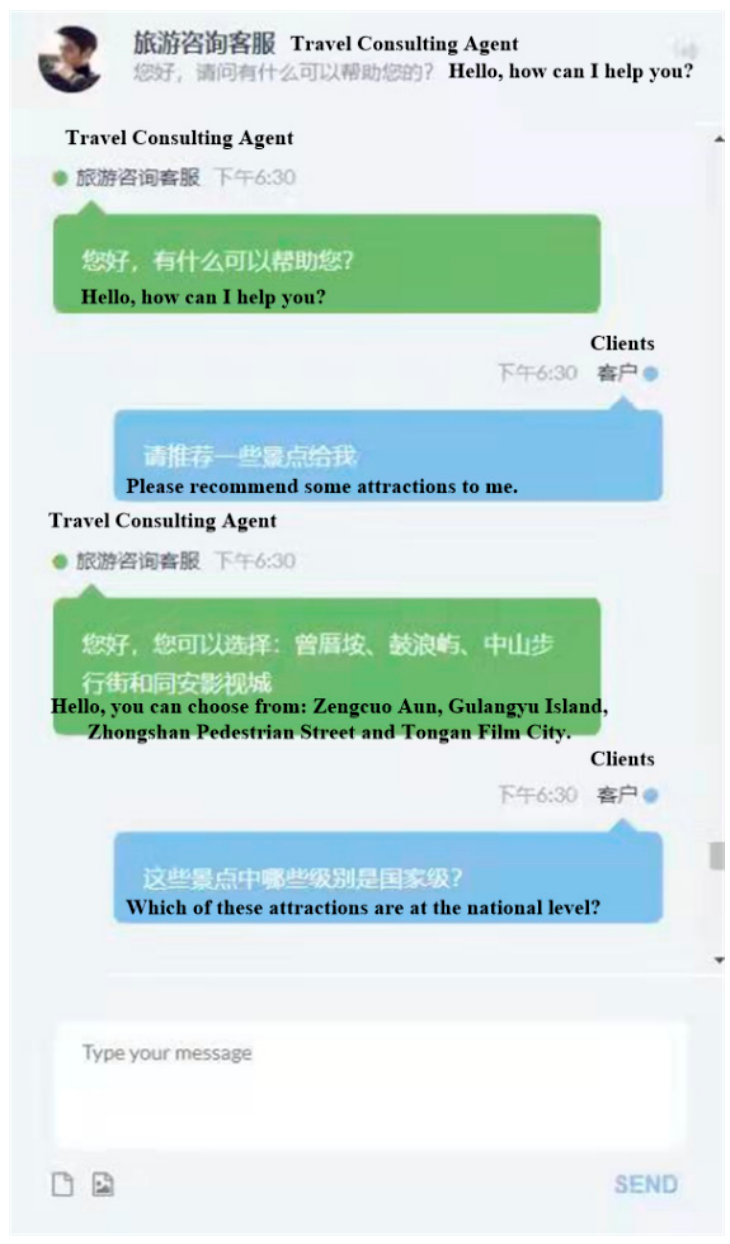
Figure 7. The system interface, where the dialogue is in Chinese